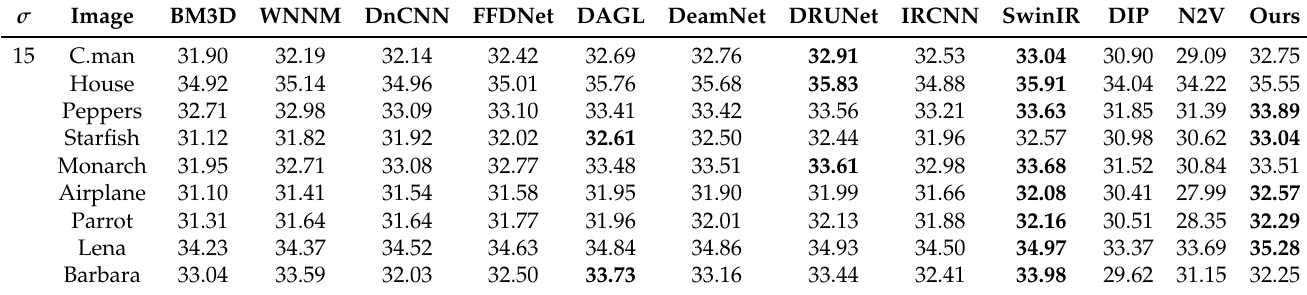
Table 4. PSNR (dB) values of different methods on 12 gray images in the Set12 dataset with noise level σ at 15, 25, and 50. The best two performances are highlighted in